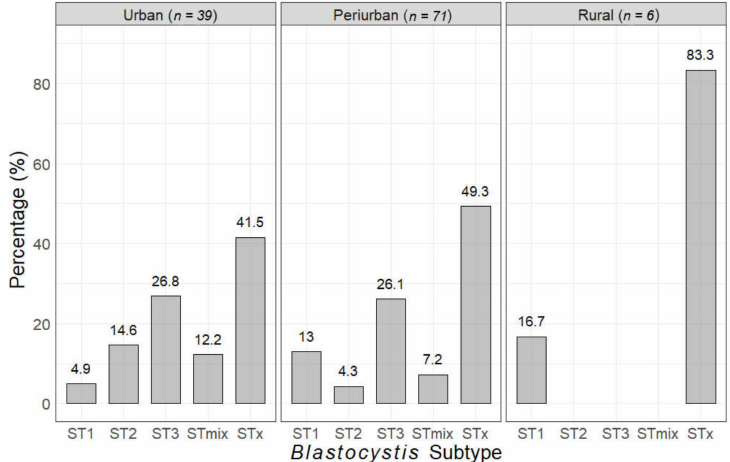
Figure 2. Blastocystis subtype distribution in each study area. STx corresponds to an unknown Blastocystis subtype and STmix corresponds to mixed subtypes.